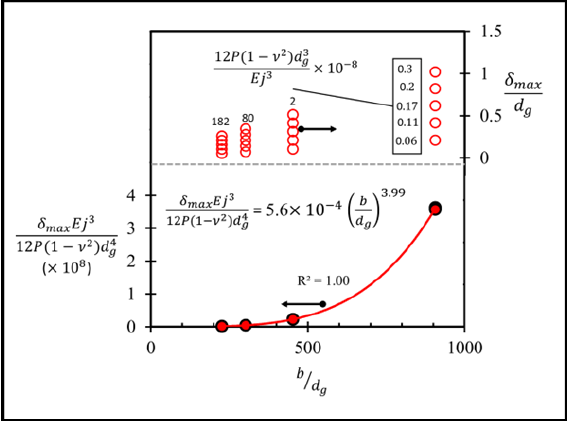
Figure 21. Variations of three dimensionless parameters in the case of sensor with local groove 𝐿𝐺2 − 𝐿𝑇 − 𝑇𝑜𝑝 at 𝑙 𝑔 ̅ = 0.35 .